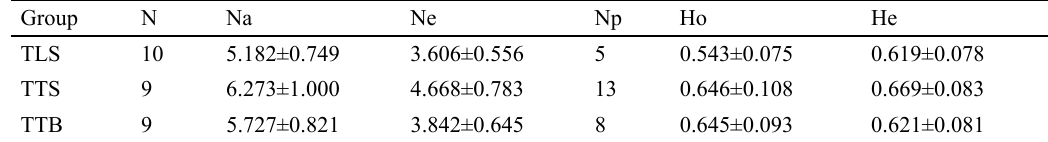
Table 3. Population genetic parameters across the three Bombus terrestris groups (TLS = B. t. lusitanicus from the Spain; TTS = B. t. terrestris from Spain; and TTB = B. t. terrestris from Belgium) based on eleven microsatellite loci (N = number of individuals, Na = number of alleles, Ne = number of effective alleles, Np = number of privative alleles, Ho = observed heterozygosity and He = expected